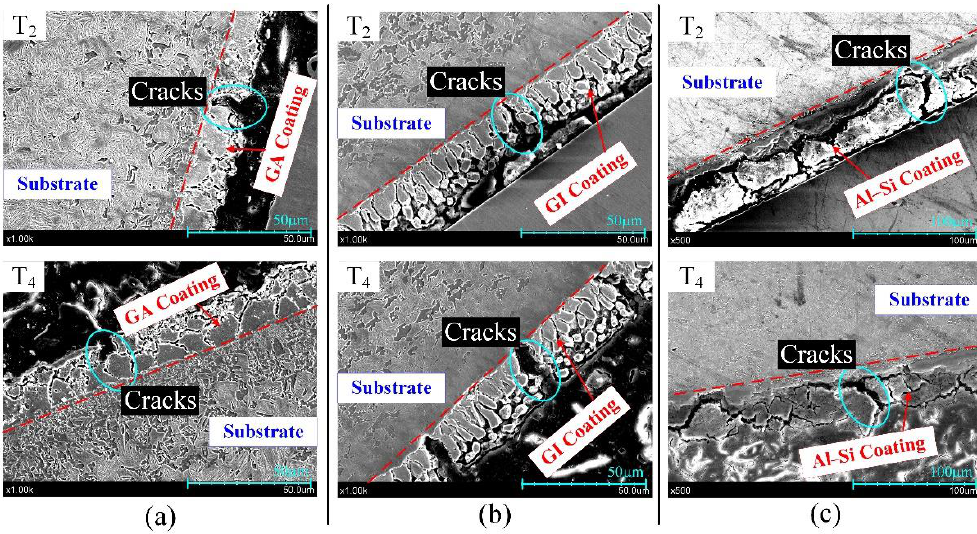
Figure 10. The microstructure of coatings at T2 and T4: ( a ) GA coating; ( b ) GI coating; ( c ) Al–Si coating.